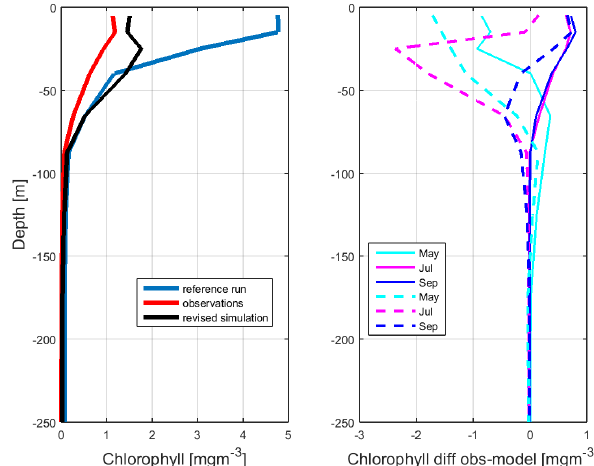
Figure 10. Profiles of difference between the nitrate [mmolNm − 3 ] model and observations in different months in the Norwegian Sea box – solid lines (blue) are the revised simulation and dashed lines (red) the control run. All observations in the Norwegian Sea box between 1998 and 2001 have been used.